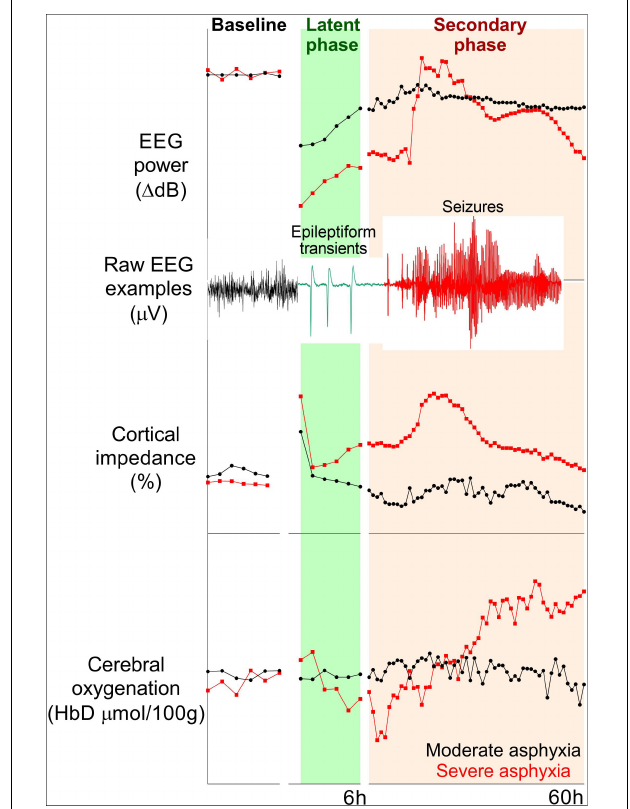
FIGURE 1 | Examples of changes in EEG power (top panel), cortical impedance (middle panel), and cerebral oxygenation (difference in oxygenated and deoxygenated hemoglobin, bottom panel) during baseline and 60 h post-HI recovery in near-term (0.85 gestation) fetal sheep subjected to 15 min ( n = 2) or 18 min ( n = 2) complete umbilical cord occlusion. Fifteen and eighteen minutes of asphyxia reflect moderate and severe HI, respectively. In the moderate group, total EEG power remained suppressed, but epileptiform transient activity on a suppressed background was seen during the latent phase. High amplitude, stereotypic seizures developed during the secondary phase. EEG power in the severe group increased with the onset of status epilepticus and subsequently fell below the moderate group. A secondary rise in impedance (delayed cell swelling) was only seen in the severe group. Cerebral oxygenation remained stable in the moderate group, but the severe group had early reduction and subsequent increase in cerebral oxygenation during the secondary